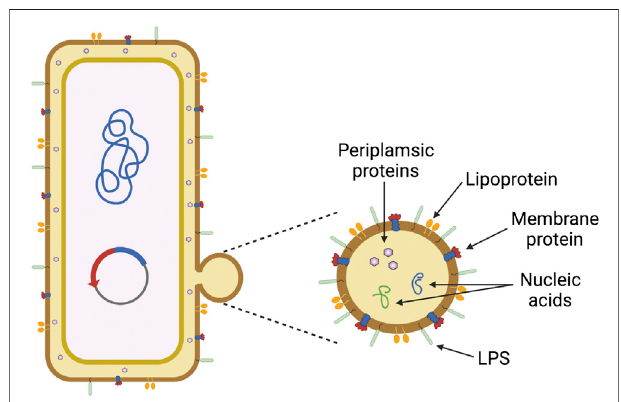
FIGURE6| Outermembranevesicles(OMVs)andpathogen-associated molecular patterns (PAMPs). OMVs naturally bud from the bacterial outer membrane (left), which allows them to display many bacterially-derived PAMPs (right) that activate toll-like receptors (TLRs) to enhance the memory response. This fi gure was generated using